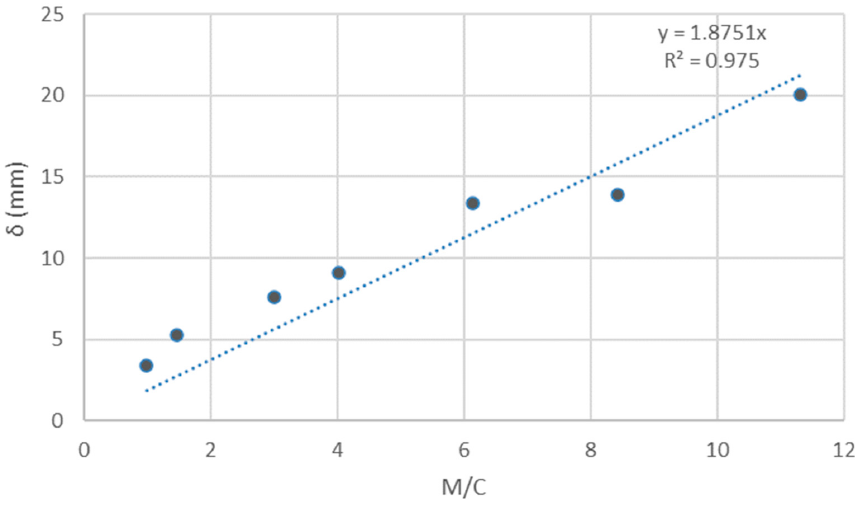
Figure 6. Influence of M/C on the depth of